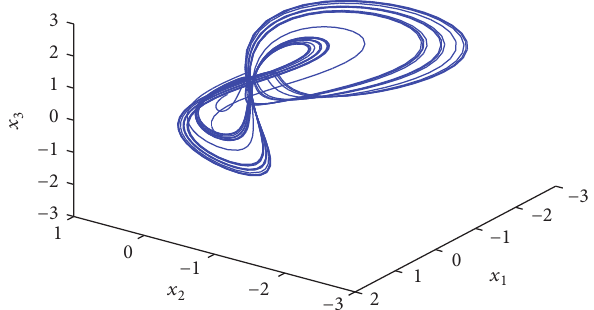
Figure 1: The chaotic attractor of the Sprott G system.